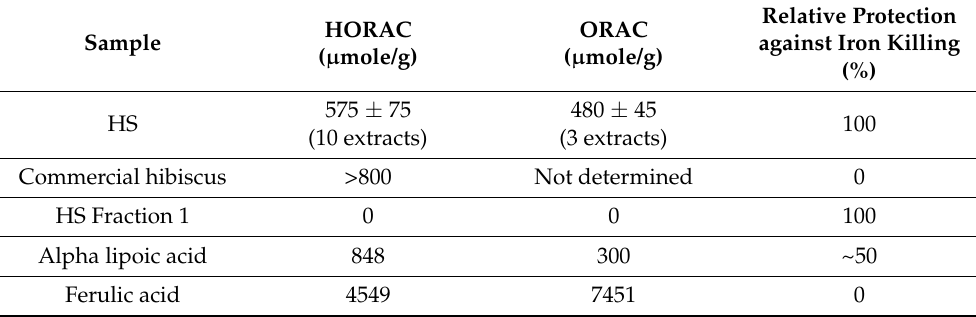
Table 1. The HORAC and ORAC activities do not predict protection against neuronal